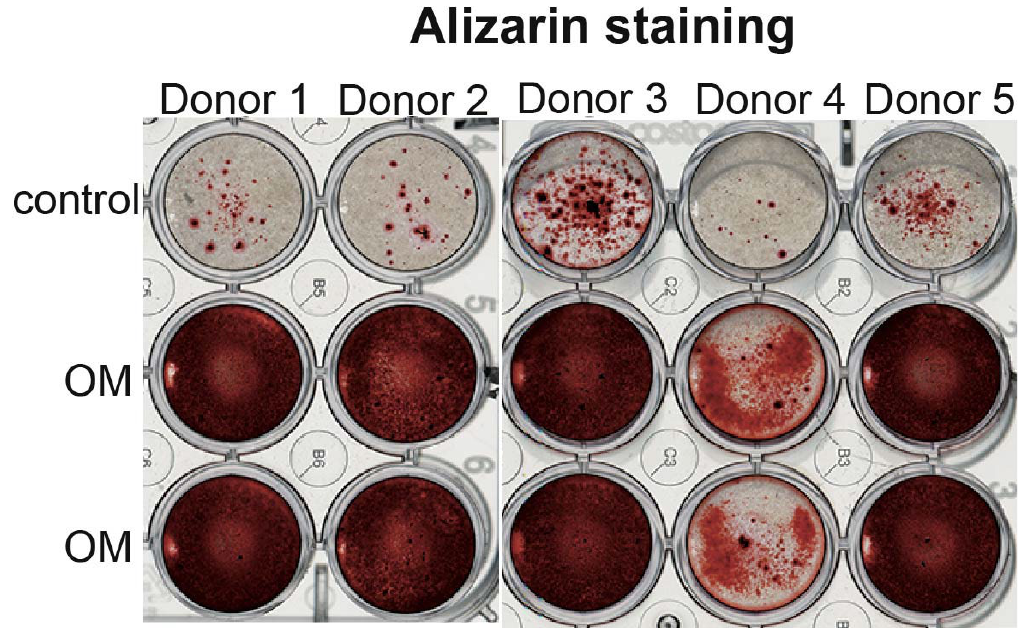
Figure 4. OB cells are able to osteo differentiation. Alizarin staining of OB cells in the control condition and on the 21st day of differentiation in osteogenic medium (OM).